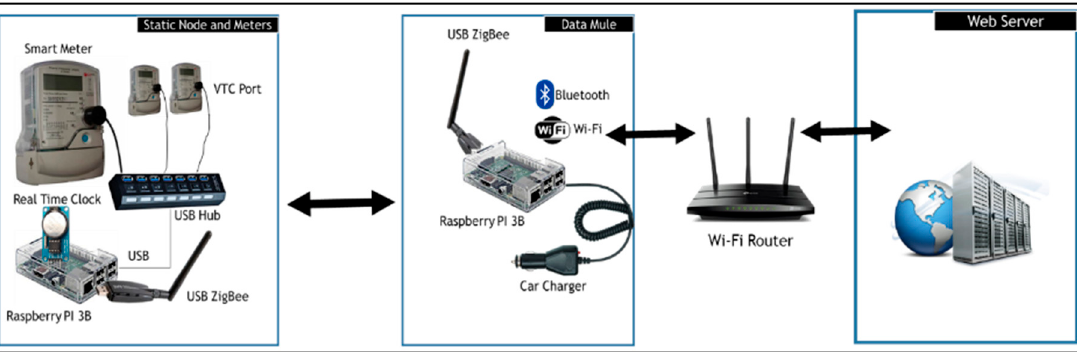
Figure 4. Proposed Architecture for Low Number of meters.